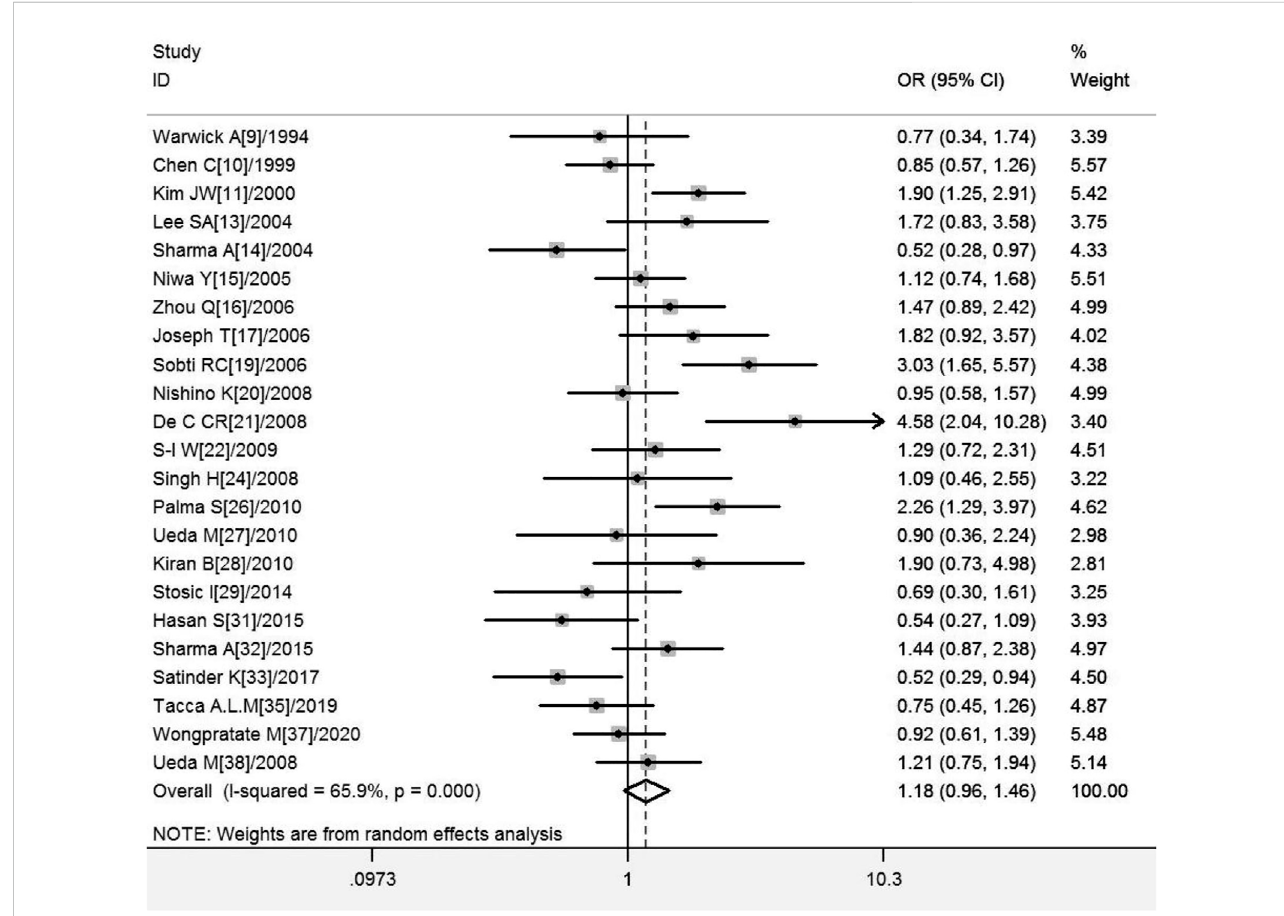
FIGURE 3 Forest plot of meta-analysis of the relationship between GSTT1 gene polymorphisms and cervical cancer